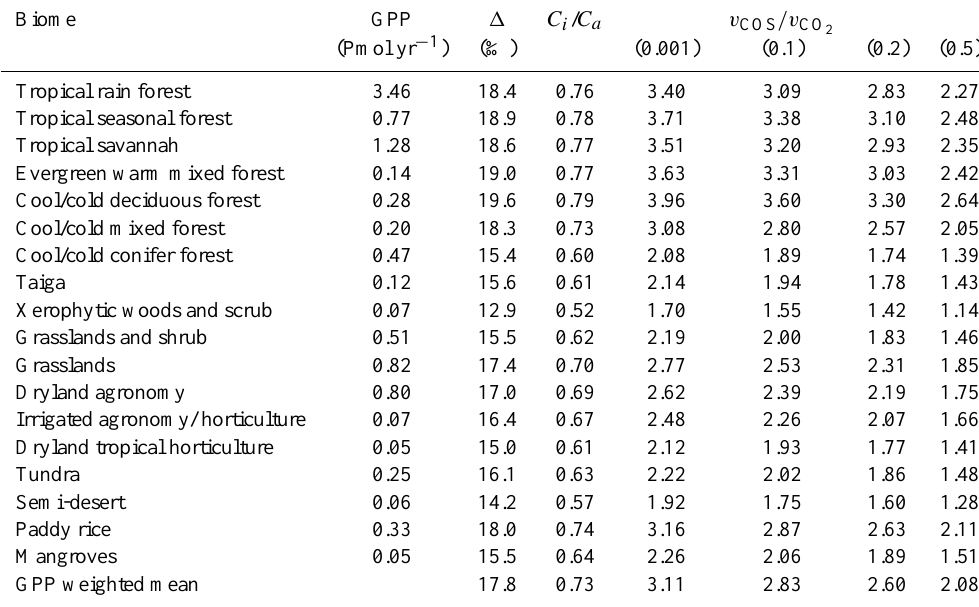
Table 3. Normalized uptake ratios of COS to CO 2 ( v COS /v CO ) and C i / C a obtained from estimates of 13 C discrimination ( 1 ) during 2 photosynthesis (Lloyd and Farquhar, 1994), assuming that internal conductance is a negligible ( g s COS /g i COS =0.001), intermediate (0.1, 0.2), or large (0.5) limitation in the diffusional pathway of